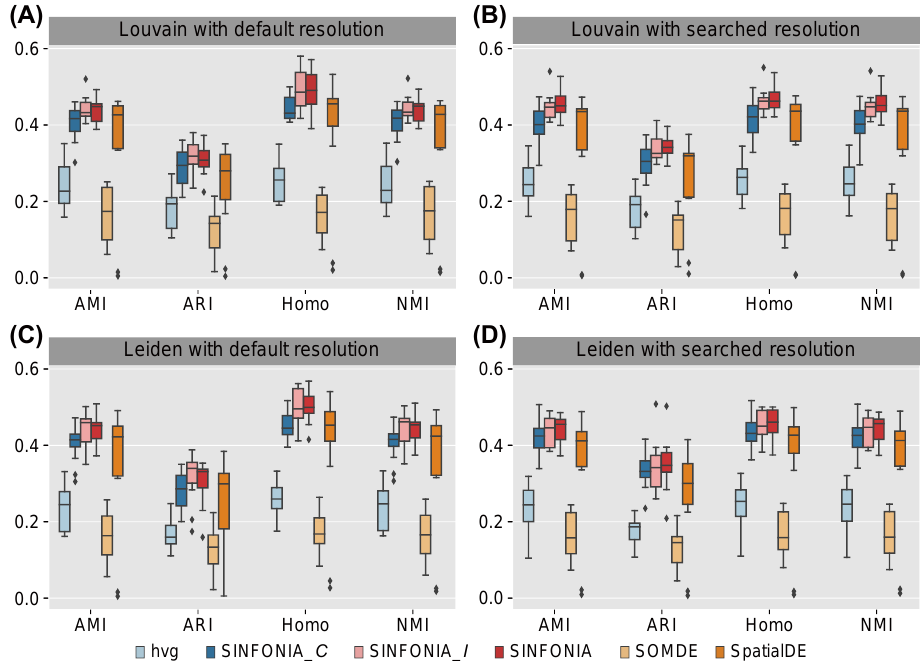
Figure 2. Louvain clustering results with ( A ) default resolution and ( B ) searched resolution (given a specified number of clusters) on 12 DLPFC datasets. Leiden clustering results with ( C ) default resolution and ( D ) searched resolution on 12 DLPFC datasets.